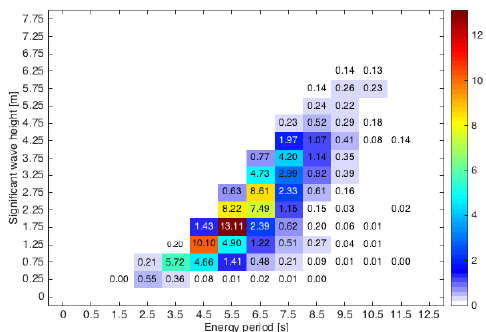
Figure 10. Annual energy conversion in % delivered for each sea state occurrence at Site 6. The red square at (5.5 s, 1.75 m) gives the highest percentage among all the sea states.